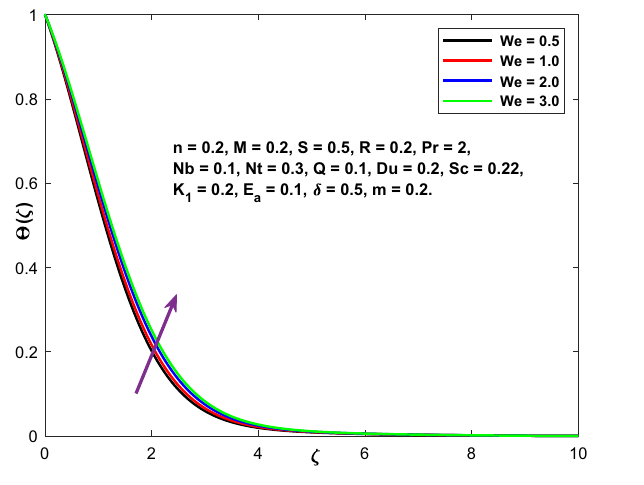
Figure 7. Character of We versus �(ζ) .